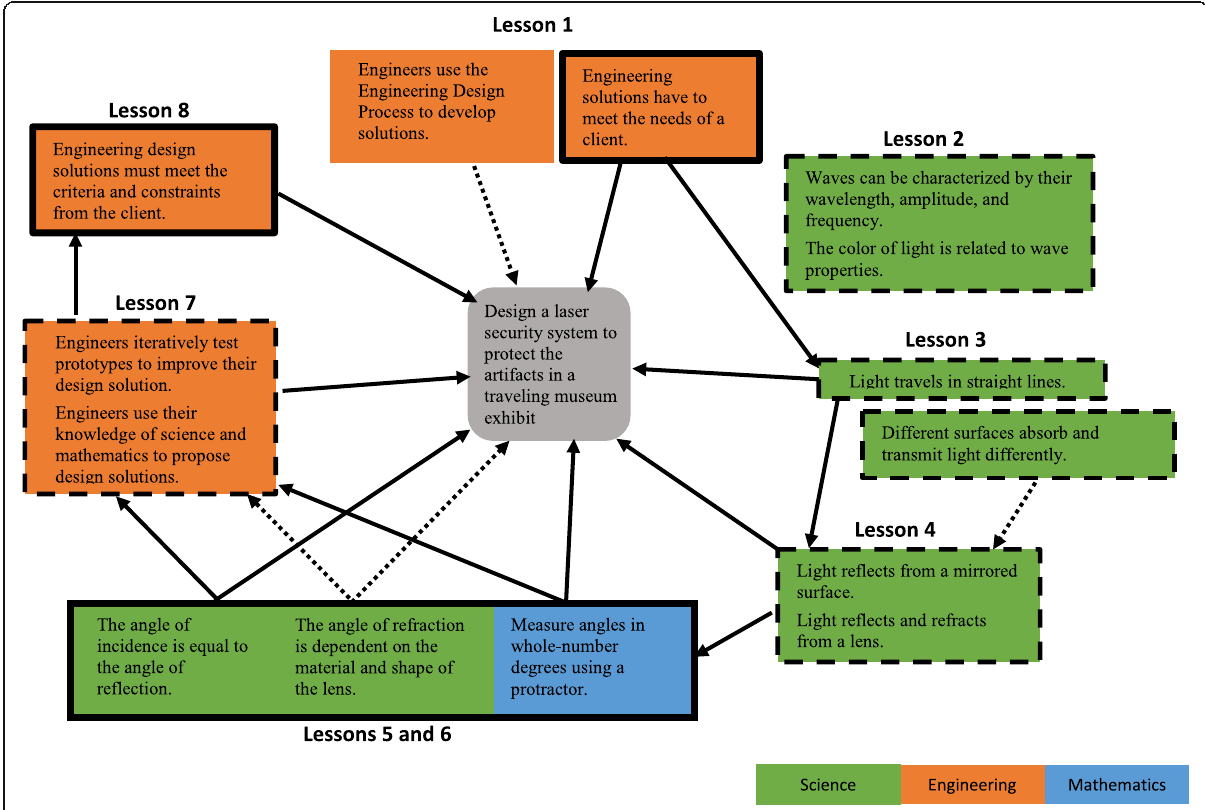
Fig. 1 Conceptual flow graphic for the Museum Security